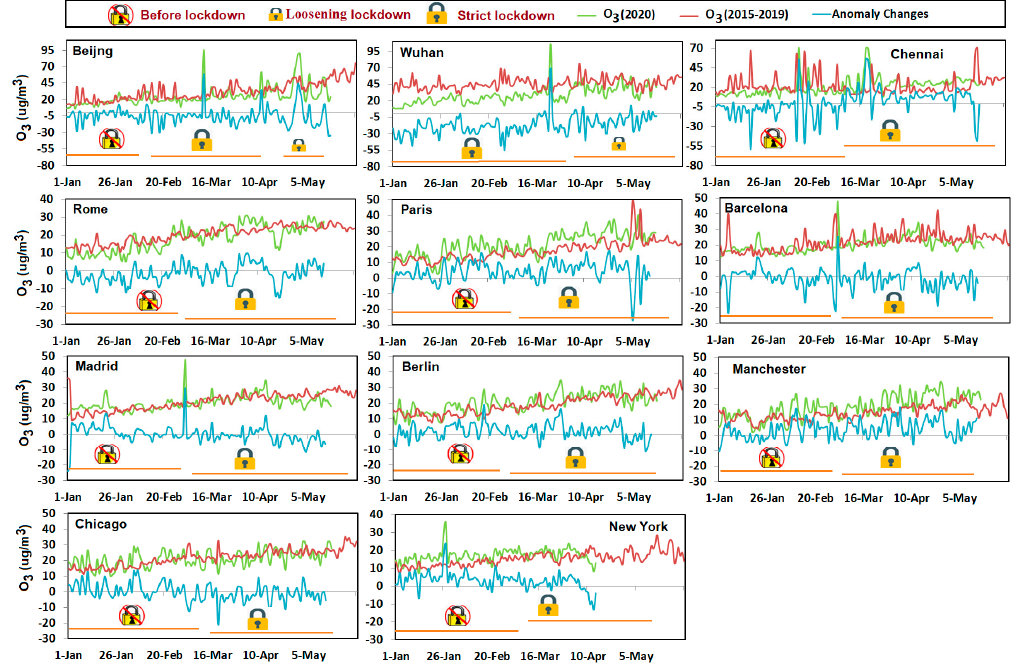
Figure 11. Daily mean ozone (O 3 ) and its anomaly changes compared to the average of past years (2015–2019) over different major cities in 2020.